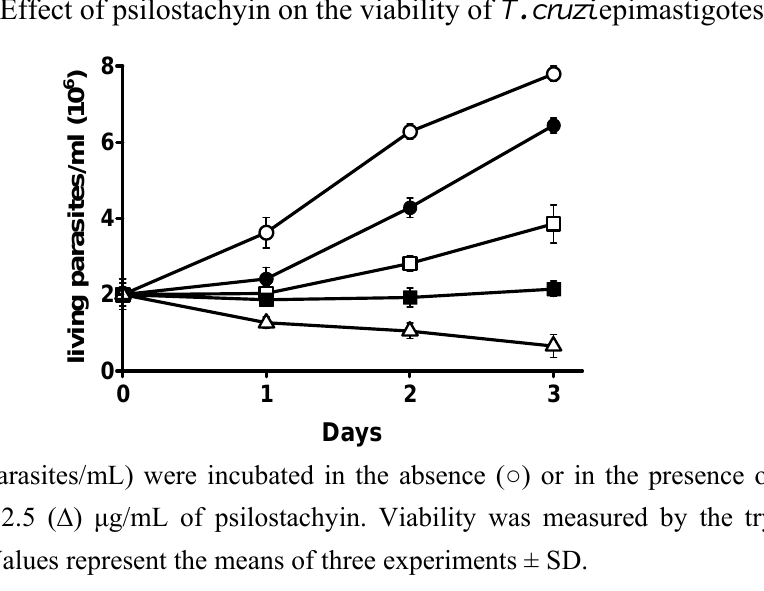
Figure 2. Effect of psilostachyin on the viability of T. cruzi epimastigotes.